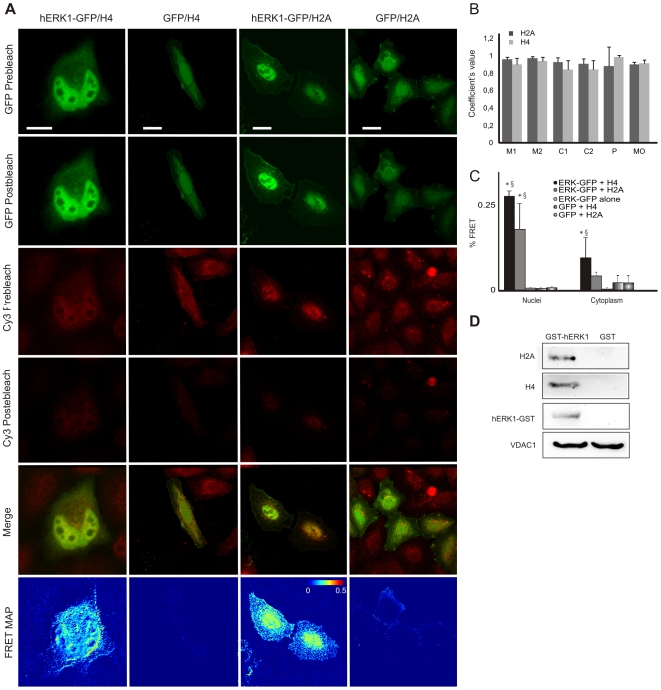
hERK1 interaction with histones.(A) HeLa cells transfected with hERK1-GFP, fixed and labelled with antibodies to H2A and H4 and a secondary antibody conjugated with Cy3. GFP and Cy3 images prior and after Cy3 photobleaching, a merged image of GFP and Cy3 prior to photobleaching and a FRET map in accord to Eq. 1 are shown. Bar = 10 µm. Color bar = FRET efficiency. Negative control: same FRET experiment in HeLa cells transfected with GFP and further stained against histones as above. Representative images are shown. (B) Colocalization indexes. M and C coefficients were estimated for both green and red images (Mgreen, Mred, Cgreen, Cred). P = Pearson's correlation coefficient, MO = Manders Overlap Coefficient. (C) Mean FRET efficiency estimated and analyzed as in Fig. 3; *p<0.5 with respect to GFP transfected cells. §p<0.5 with respect to hERK1-GFP transfected cells with no histone or Cy3 staining. (D) Pulldown experiment performed as in Fig. 2, with proteins detected by western blotting.